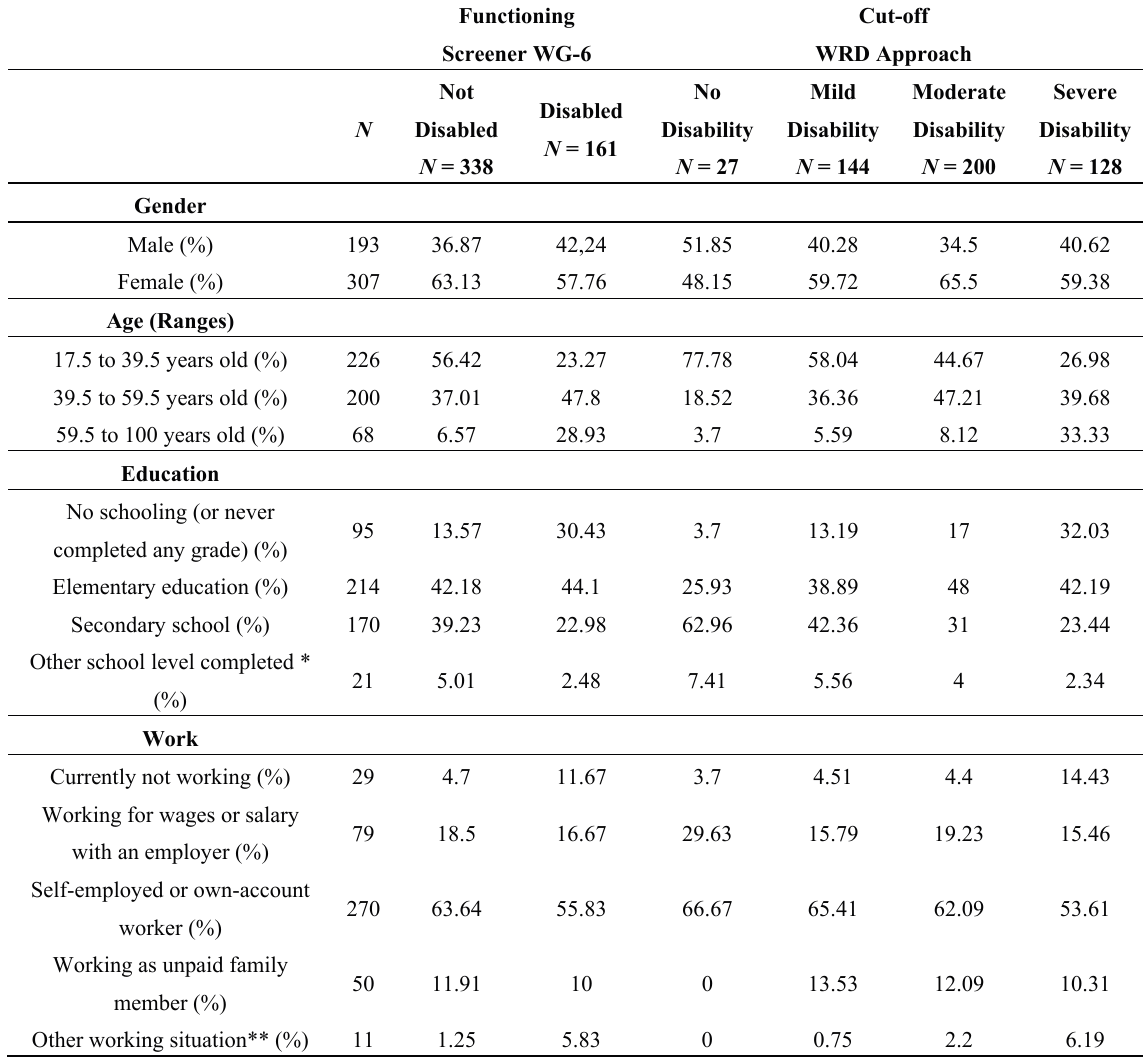
Table 5. Comparison of the functioning screener approach and the WRD approach regarding gender, age, education and